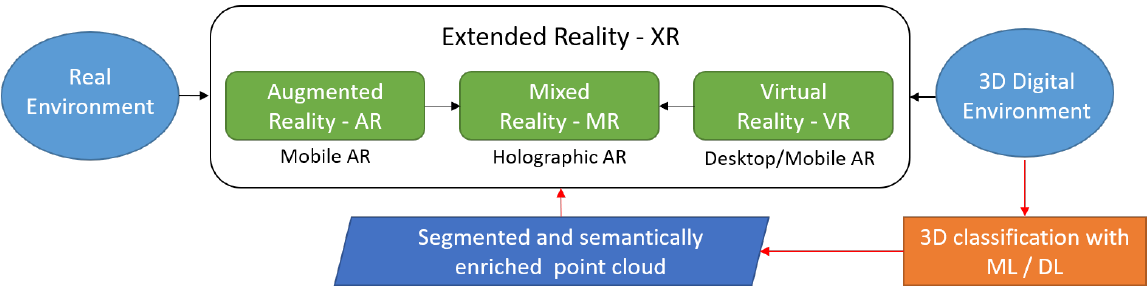
Figure 1. The reality-virtuality continuum of technologies (adapted from connected Milgram and Kishino, 1994) connected to 3D point cloud classification